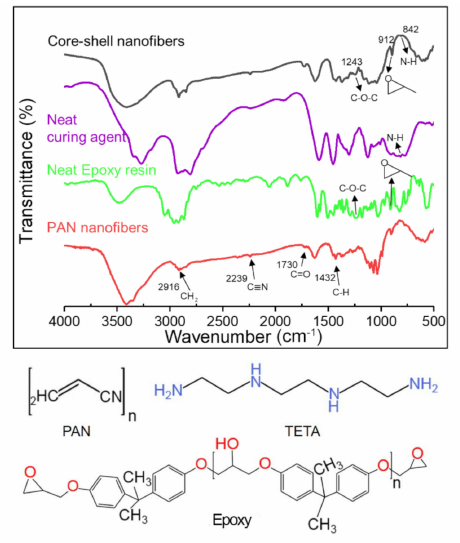
Figure 5. Fourier transform infrared (FTIR) spectra of PAN fibers, neat epoxy resin, neat curing agent, and core-shell